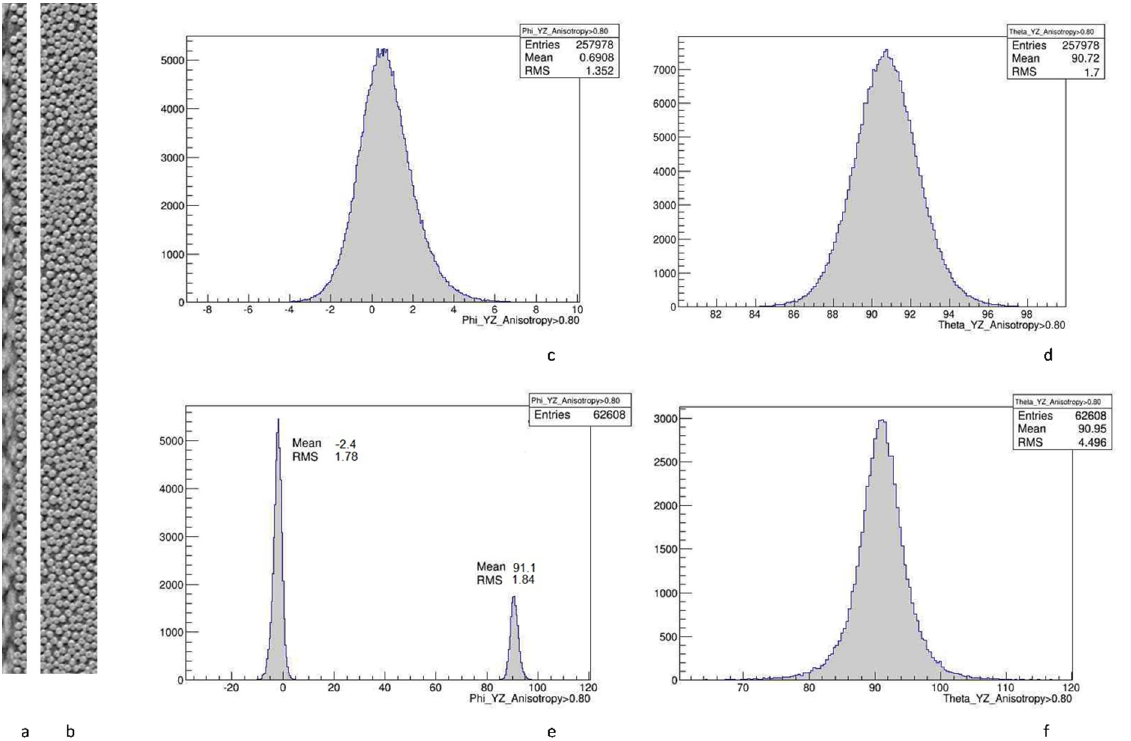
Figure 6. Typical fiber orientation analysis, image BSL21: ( a ) interface 90°/0°; ( b ) inside ply 0°; ( c ) in ‐ plane fiber orientation angle, inside 0°; ( d ) out ‐ of ‐ plane fiber orientation angle, inside 0°; ( e ) in ‐ plane fiber orientation angle, interface 90°/0°; ( f ) out ‐ of ‐ plane fiber orientation angle, interface 90°/0°.